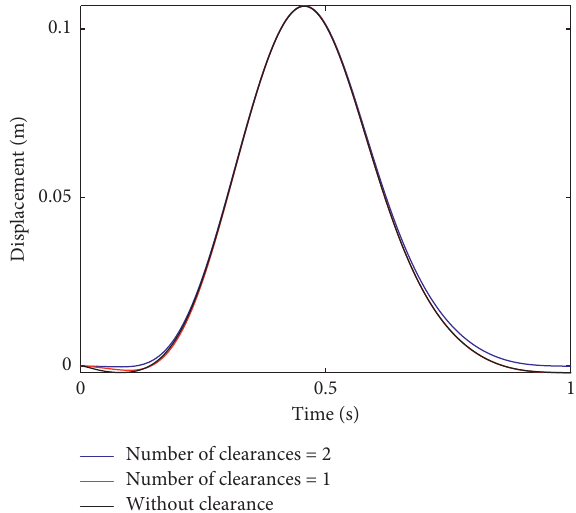
Figure 11: Acceleration of the slider with different numbers of clearances.